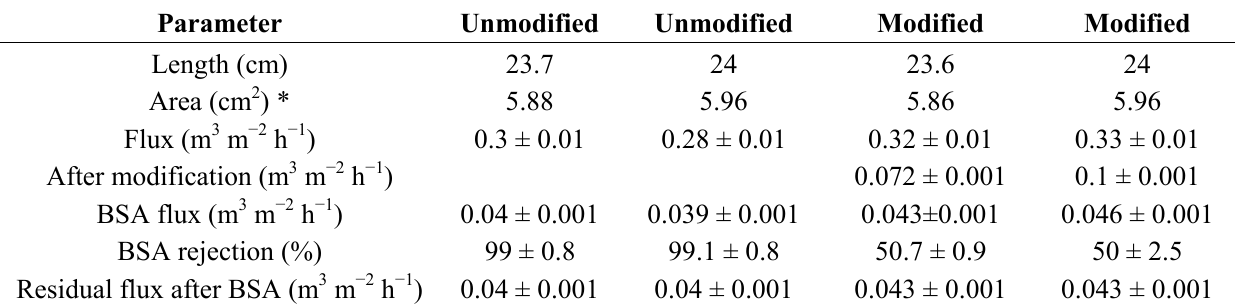
Table 1. Specification and performance of the unmodified and modified high flush surface hollow single fiber polyethersulfone (PES) lab modules.